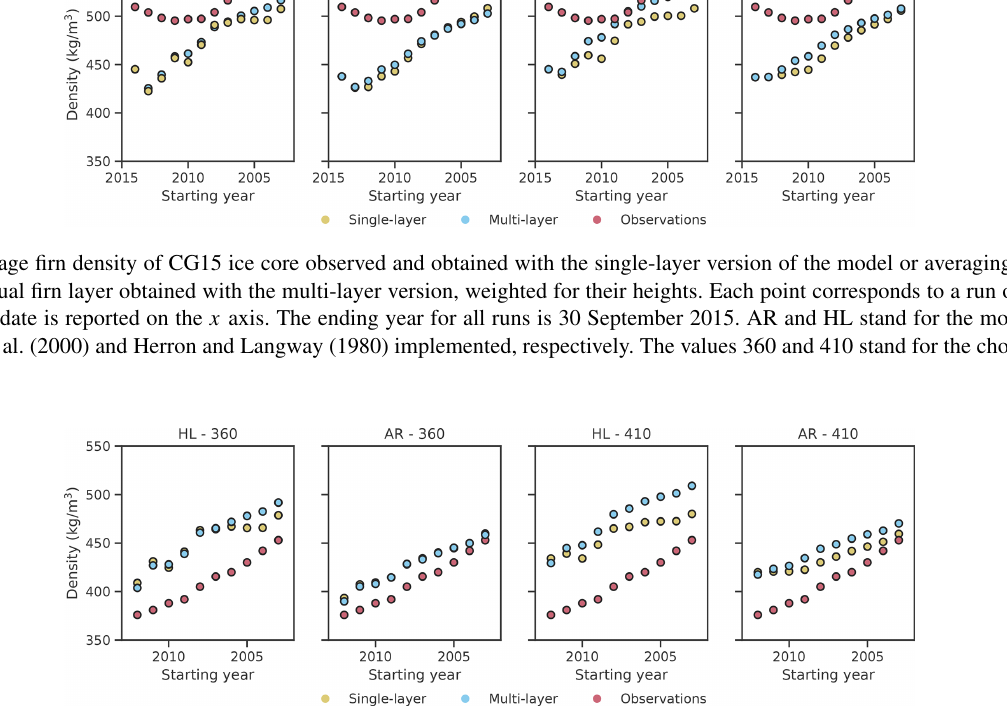
Figure 10. Average firn density of KCC ice core observed and obtained with the single-layer version of the model or averaging the density of each individual firn layer obtained with the multi-layer version, weighted for their heights. Each point corresponds to a run of the model whose starting date is reported on the x axis. The ending year for all runs is 30 August 2013. AR and HL stand for the model versions with Arnaud et al. (2000) and Herron and Langway (1980) implemented, respectively. The values 360 and 410 stand for the chosen value of ρ D